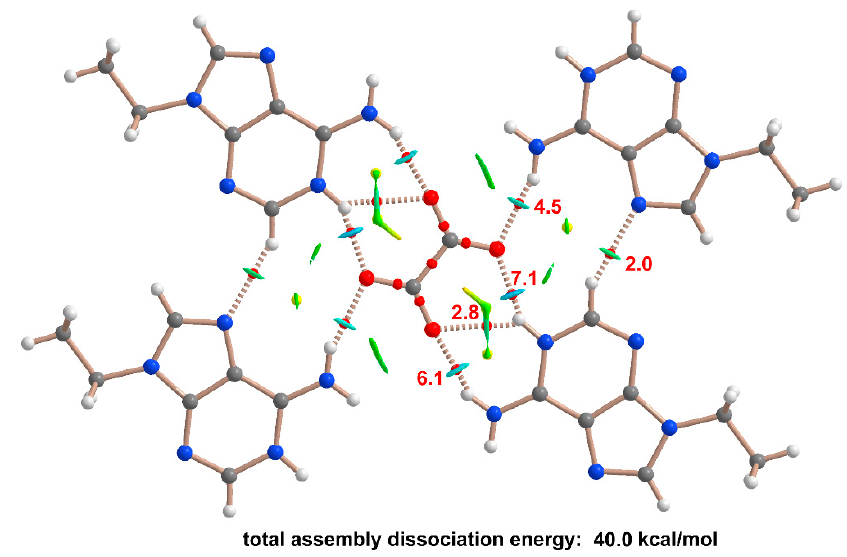
Figure 8. QTAIM distribution of bond and ring critical points (CPs, red and yellow spheres, respec- tively) corresponding to the H-bonds in the R 22 (10) synthons and its interaction with four surround- ing [C 2 O 4 H] – anions. The dissociation energies of the H-bonds are indicated next to the bond CPs. Superimposed NCIplot isosurfaces [ s = 0.5, cut-off = 0.04 a.u., color scale –0.04 a.u. (blue) ≤ (sign λ 2 ) ρ ≤ 0.04 a.u. (red)] are also represented.